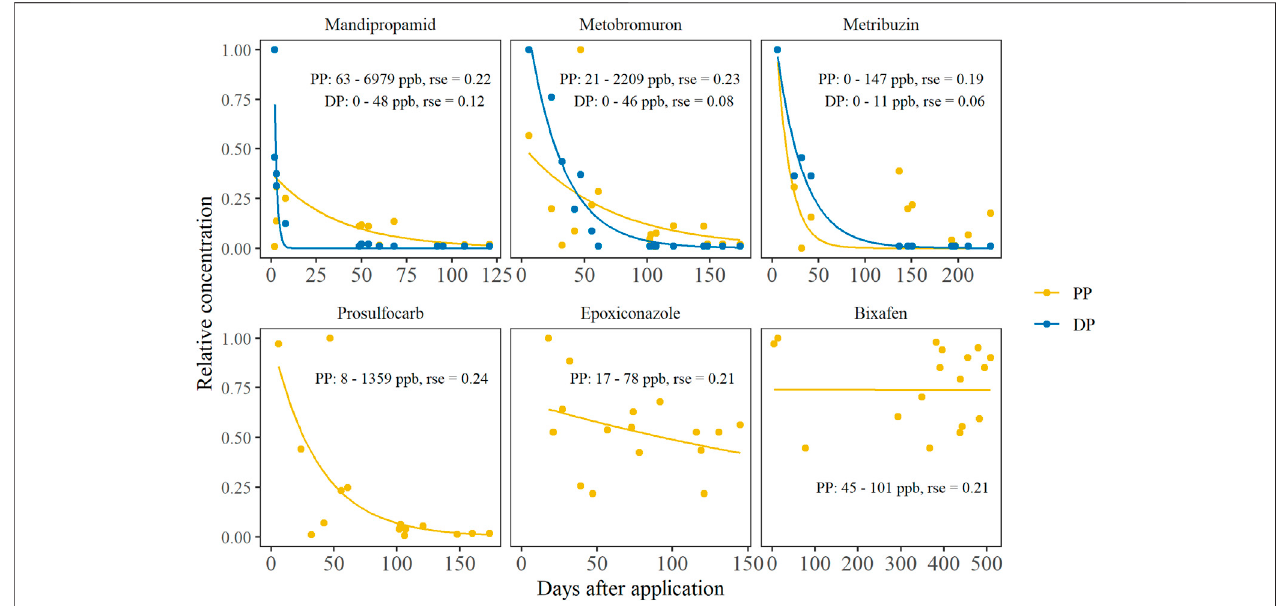
FIGURE4 | Decrease ofthe relative concentrations inDP and PP forsix AS.The concentration range (min — max) ofthe ASdetectedin runoff is given, ppb in PPis µg kg − 1 , and in DP µg L − 1 , rse is the residual standard error.